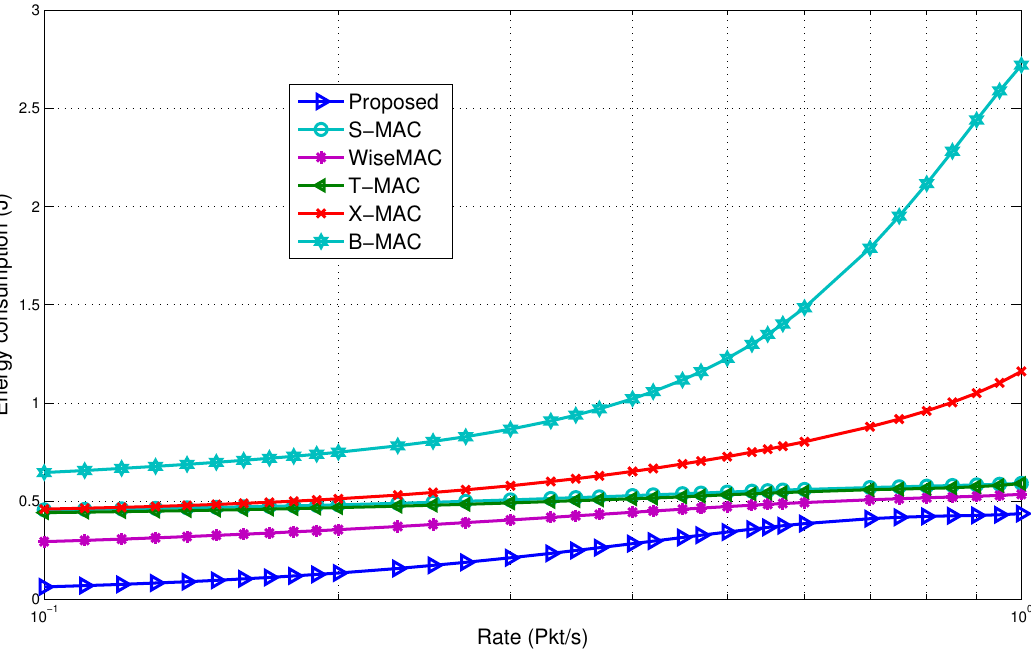
Figure 22. Energy consumption comparison with non-standard